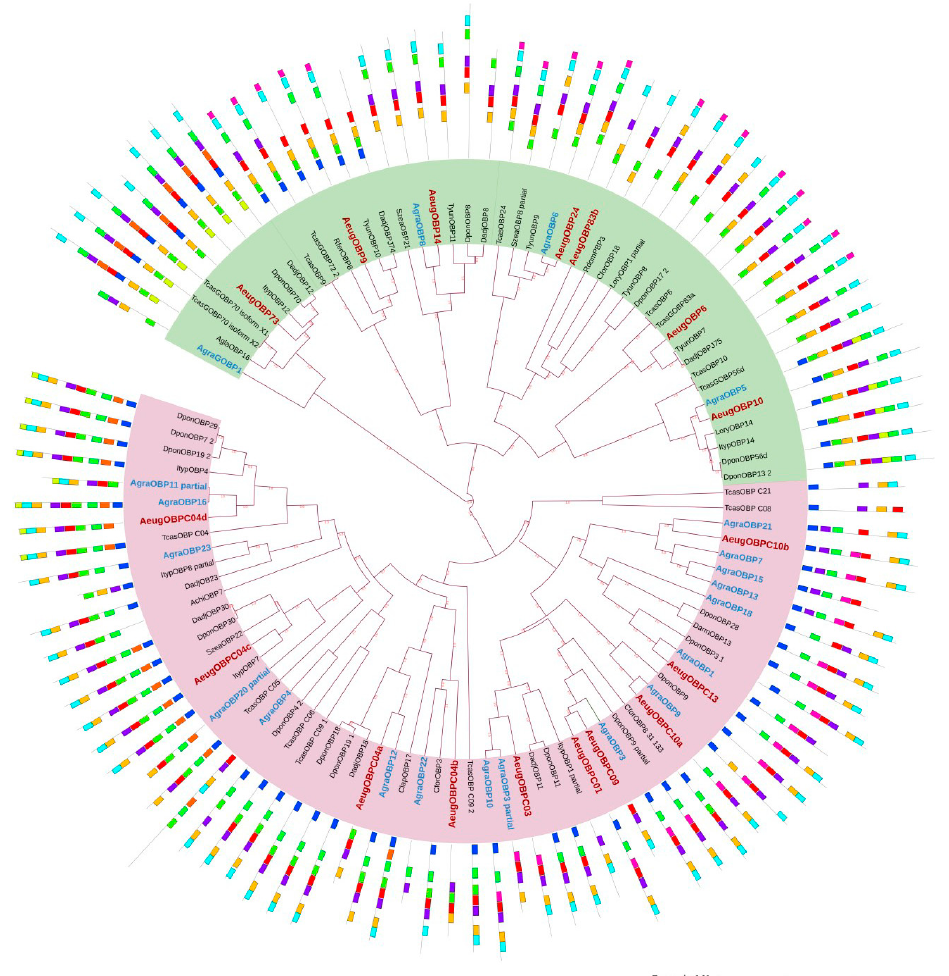
Figure 3. OBPs phylogeny by Bayesian inference. The OBP are divided into two clades: Classics (green) and OBP Minus-C (purple). Motif patterns are related per sequence; the motifs colors correspond to those described in Figure 4. Species: Anthonomus eugenii (Aeug), A. grandis (Agra), Rhynchophorus ferrugineus (Rfer), Rhyzopertha dominica (Rdom), Sitophilus zeamais (Szea), Dendroctonus adjunctus (Dadj), D. ponderosae (Dpon), Ips typographus (Ityp) Tribolium castaneum (Tcas), Cylas formicarius (Cfor), Phyllotreta striolata (Pstr), Tomicus yunannensis (Tyun), Lissorhoptrus oryzophilus (Lory), A noplophora chinensis (Achi).